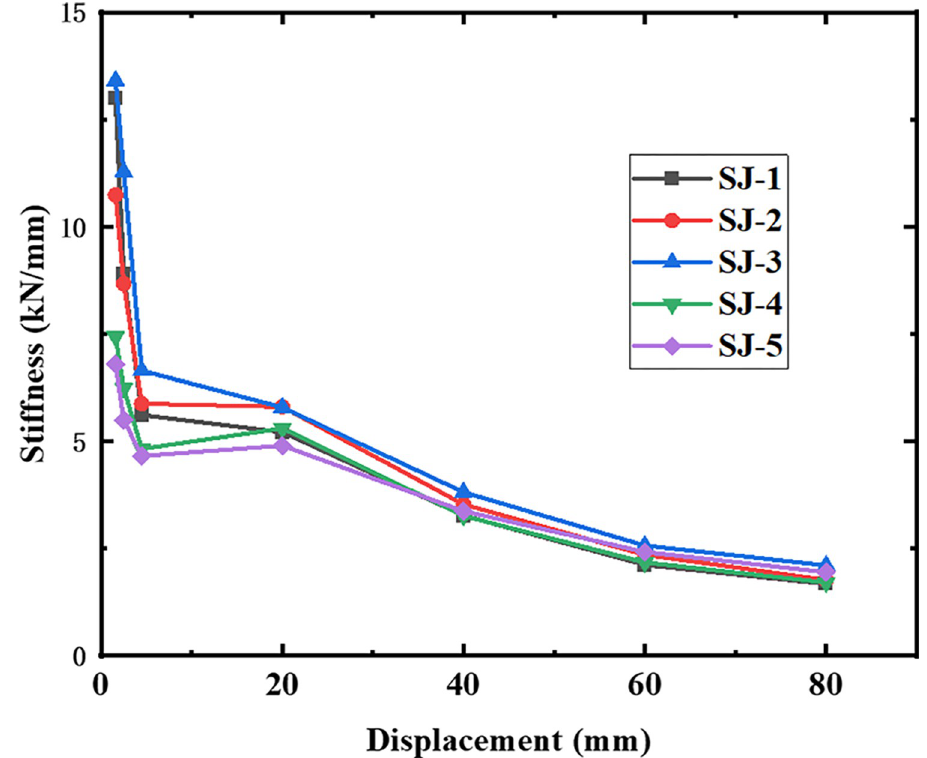
Fig 22. Stiffness degradation of the five specimens.